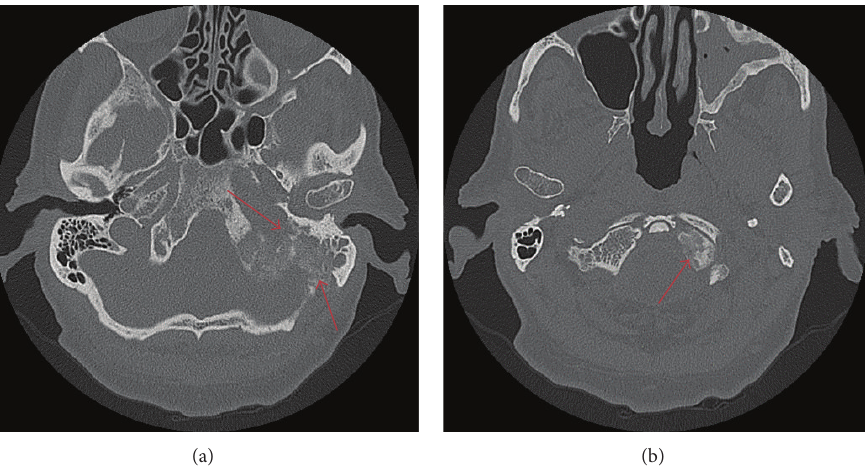
Figure 2: CT scan of the head without contrast, axial images, 8/11/2014, showing a destructive lesion centered within the left occipital bone with extension into the inferior mastoid temporal bone (a) and occipital condyle (b).